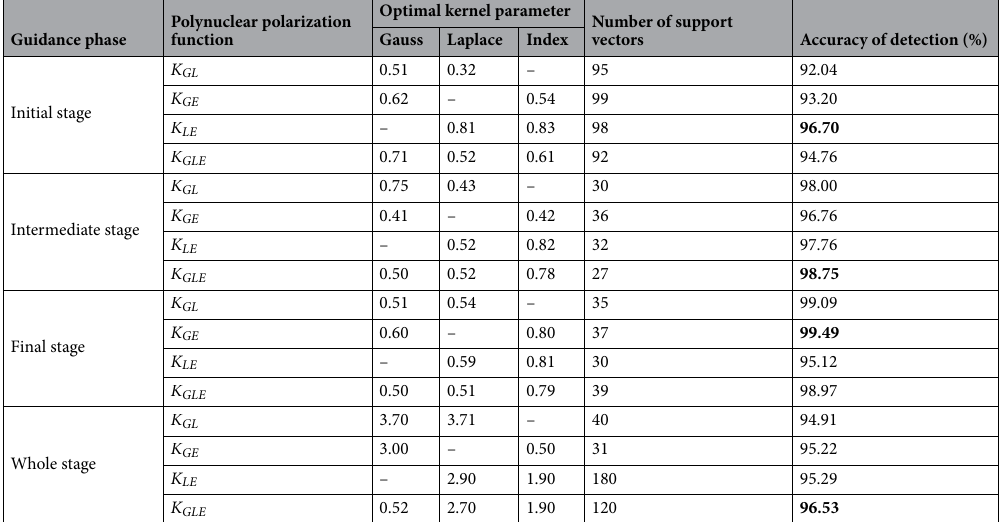
Table 4. Optimal detection results of SMP-SVDD using different polarization kernel functions at different stages. Significant values are in bold.